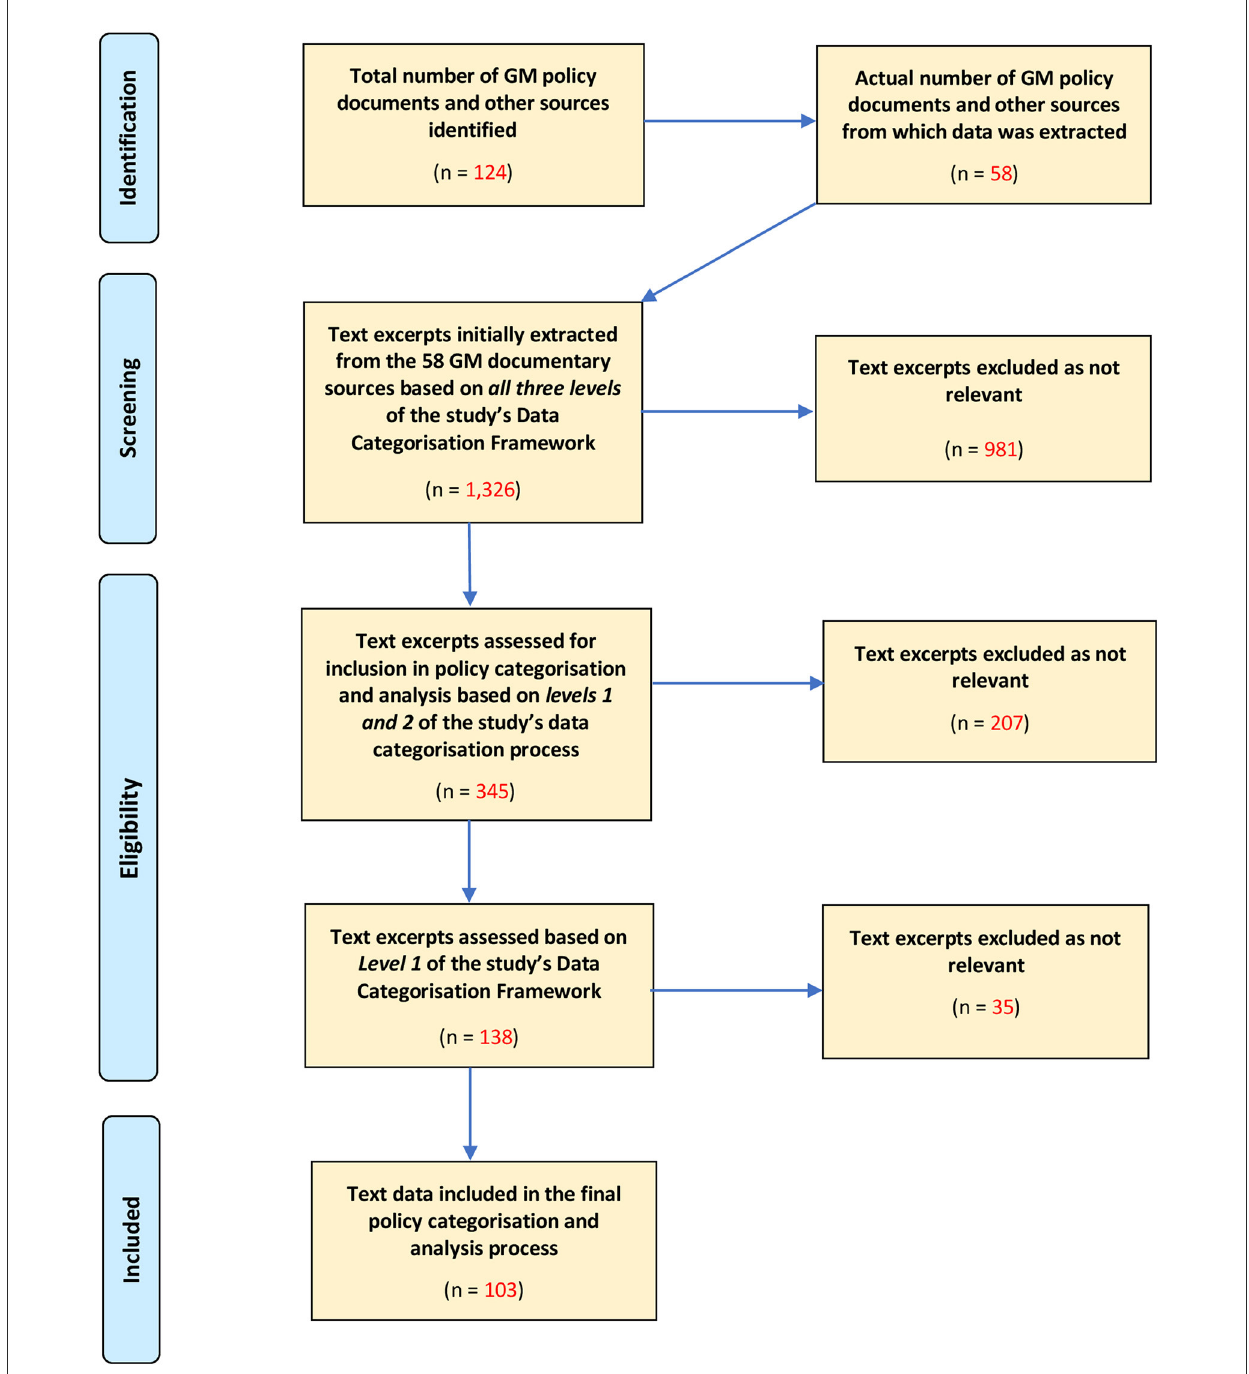
FIGURE1 Modified PRISMA diagram explaining the study’s data extraction and inclusion process.